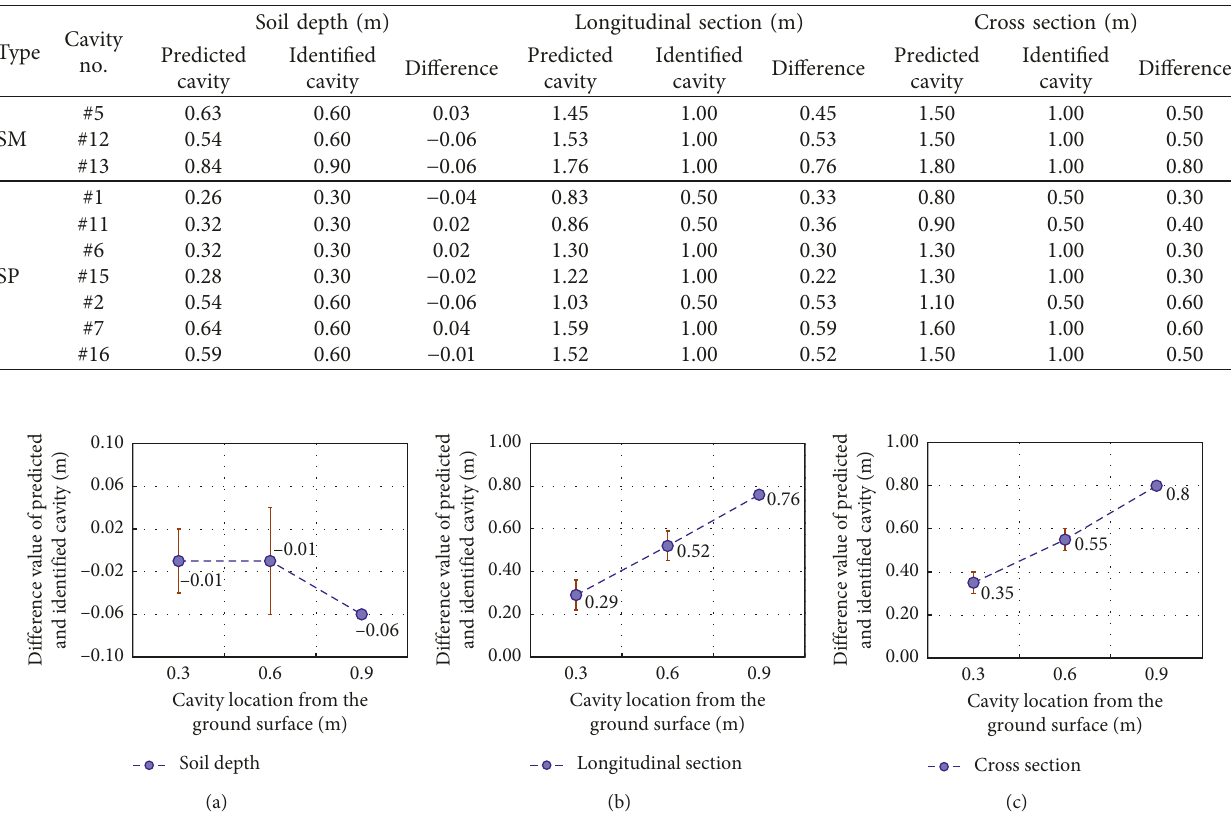
Figure 12: Difference between the predicted cavity scale and the identified cavity scale according to the location of the cavity. (a) Soil depth. (b) Longitudinal section. (c) Cross